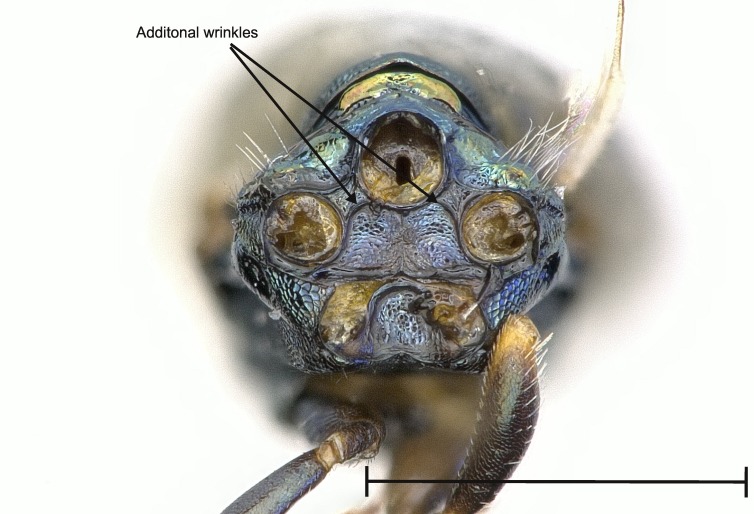

Pteromalus
inclytus.